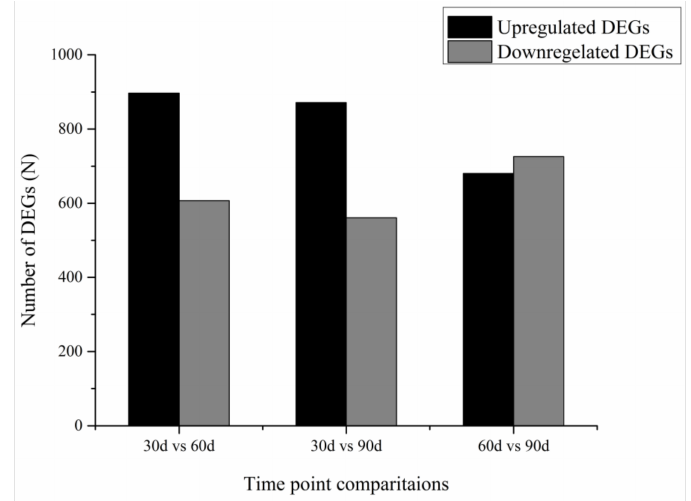
Figure 1. Statistical histogram of upregulated DEGs and downregulated DEGs in the three libraries. DEGs in the cartilage tissue of the velvet antler at the three time points were analyzed. There were more upregulated DEGs than downregulated DEGs at 30 d vs. 60 d and 30 d vs. 90 d, whereas there were fewer upregulated DEGs than down-regulated DEGs at 60 d vs. 90 d.